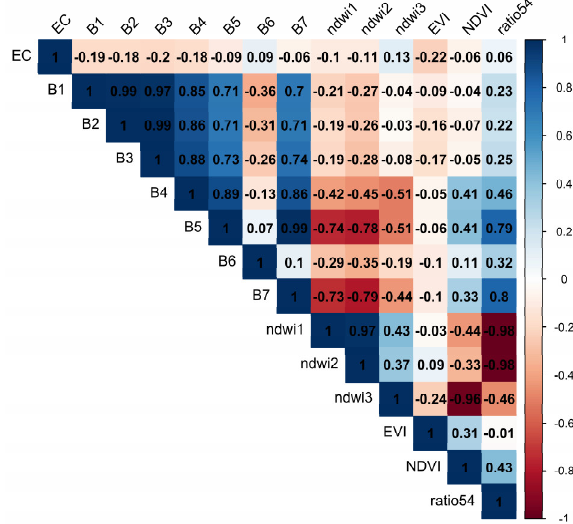
Figure 3. Correlation matrix of all